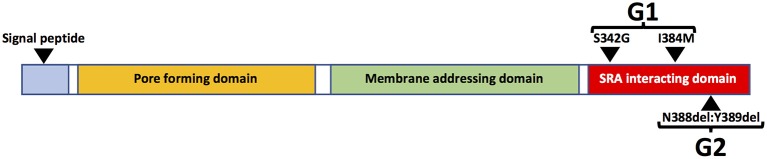
Schematic diagram of major APOL1 protein domains and G1 and G2 sequence variants.